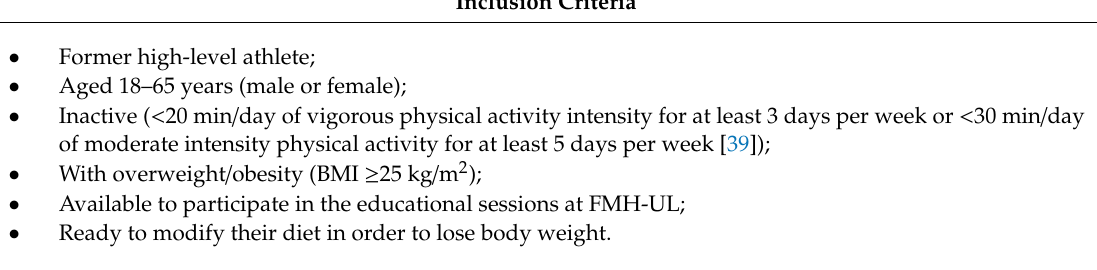
Table 2. Eligibility